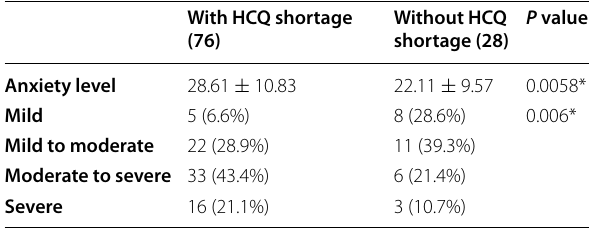
Table 4 Anxiety “Hamilton Anxiety Rating Scale” in SLE patients during COVID‑19 outbreak